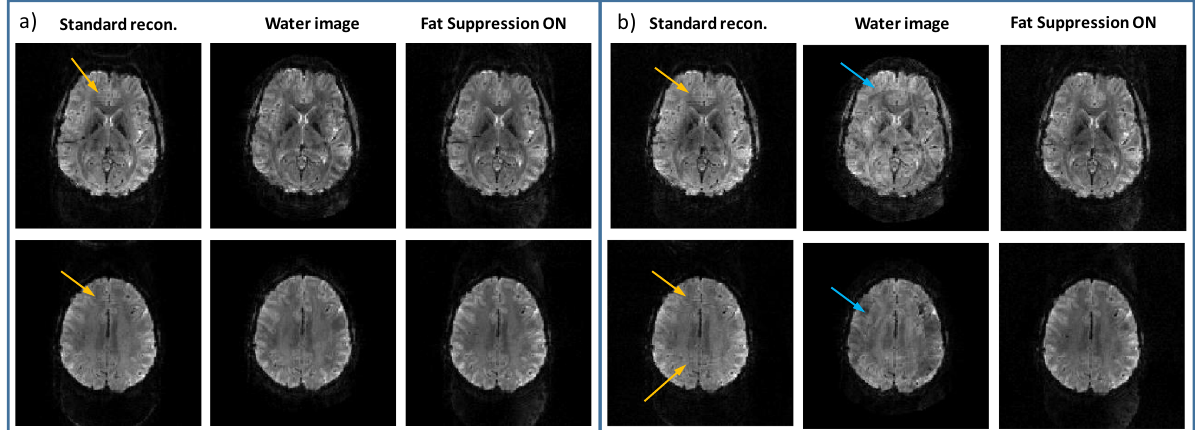
Figure 5. Human imaging—combined in-plane acceleration, SMS and lipid-water reconstruction. Two representative slices are shown for ( a ) R PE = 2 and R sms = 3 and ( b ) R PE = 2 and R sms = 4. From left to right— standard recon. (Siemens product reconstruction), water image, and lipid image from scan without fat suppression, and the image acquired with fat suppression. Yellow arrows point to the artifact due to the lipid signal in the standard reconstruction. Blue arrows point to artifacts that occur due to high acceleration factor— R tot.